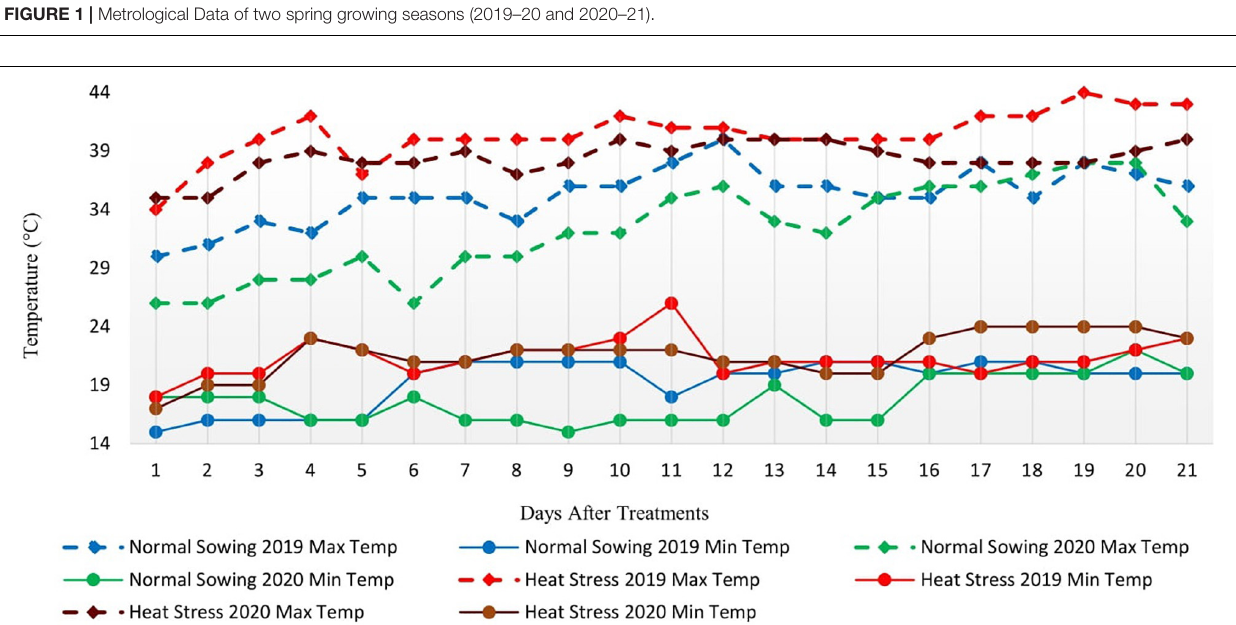
FIGURE 1 | Metrological Data of two spring growing seasons (2019–20 and 2020–21).